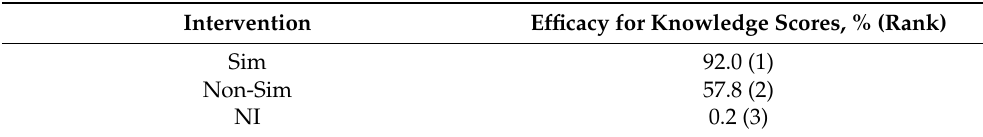
Table 1. Surface under the cumulative ranking (SUCRA) curve values and ranking of efficacy for knowledge scores.